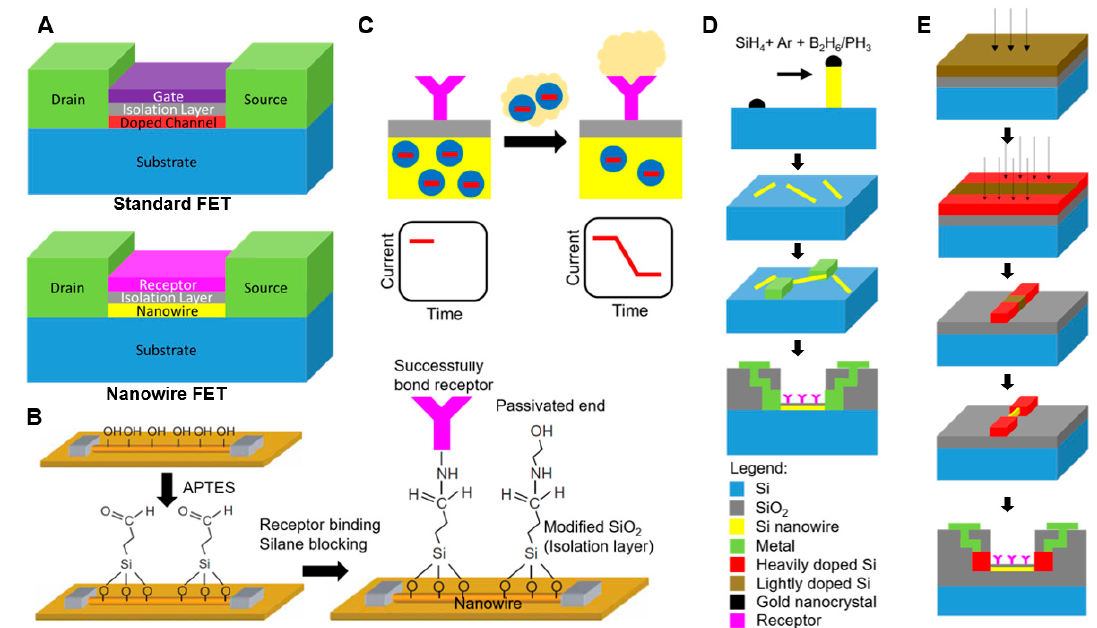
Figure 1. Conceptual overview of field effect transistors (FET) (adopted with permission from [24]). ( A ) Schematics illustrating the differences between standard and nanowire field-effect transistors. ( B ) An overview of the functionalization process of the nanowire (based on 3-aminopropoyltriethoxysilane (APTES)). The APTES converts the silicon–oxygen bonds into a silane layer, after which, it becomes possible to bind this layer with several receptors (adopted with permission from [31]). ( C ) Illustrates the operating principles of nanowire sensors. The charged molecules captured by the receptors induce variations in the conductivity of nanowire (there is either an increase or a decrease in the current that passes through it). The nanowire sensors fabricated using ( D ) the bottom-up approach and ( E ) the top-down approach.